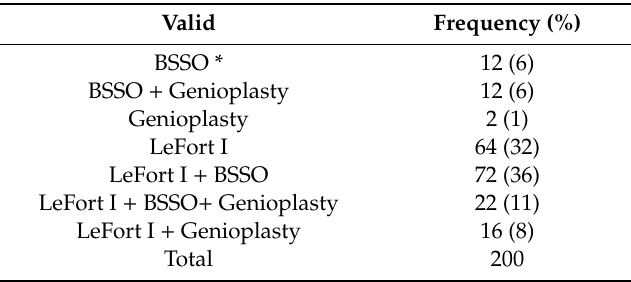
Table 6. Distribution of the osteotomy types in the